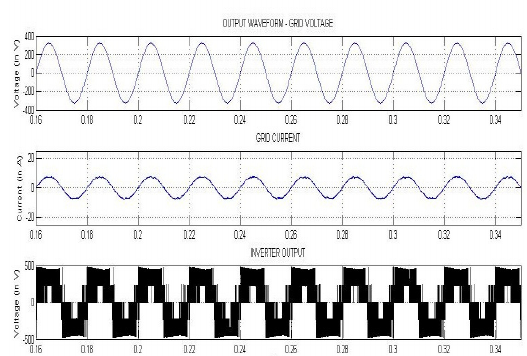
Fig 21: Peakvalues of Grid voltage, Grid current and five-level voltage